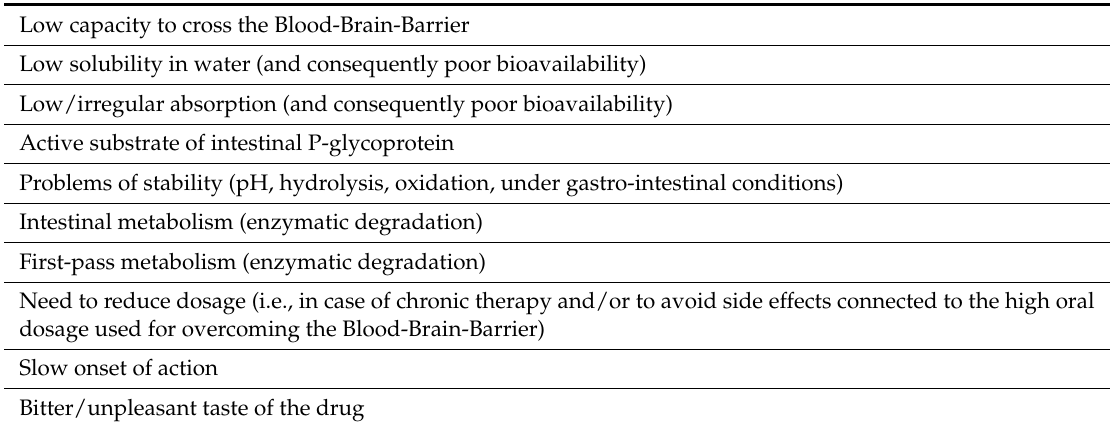
Table 1. Characteristics that make the central nervous system (CNS) drug a candidate for nasal NE, as an alternative to oral